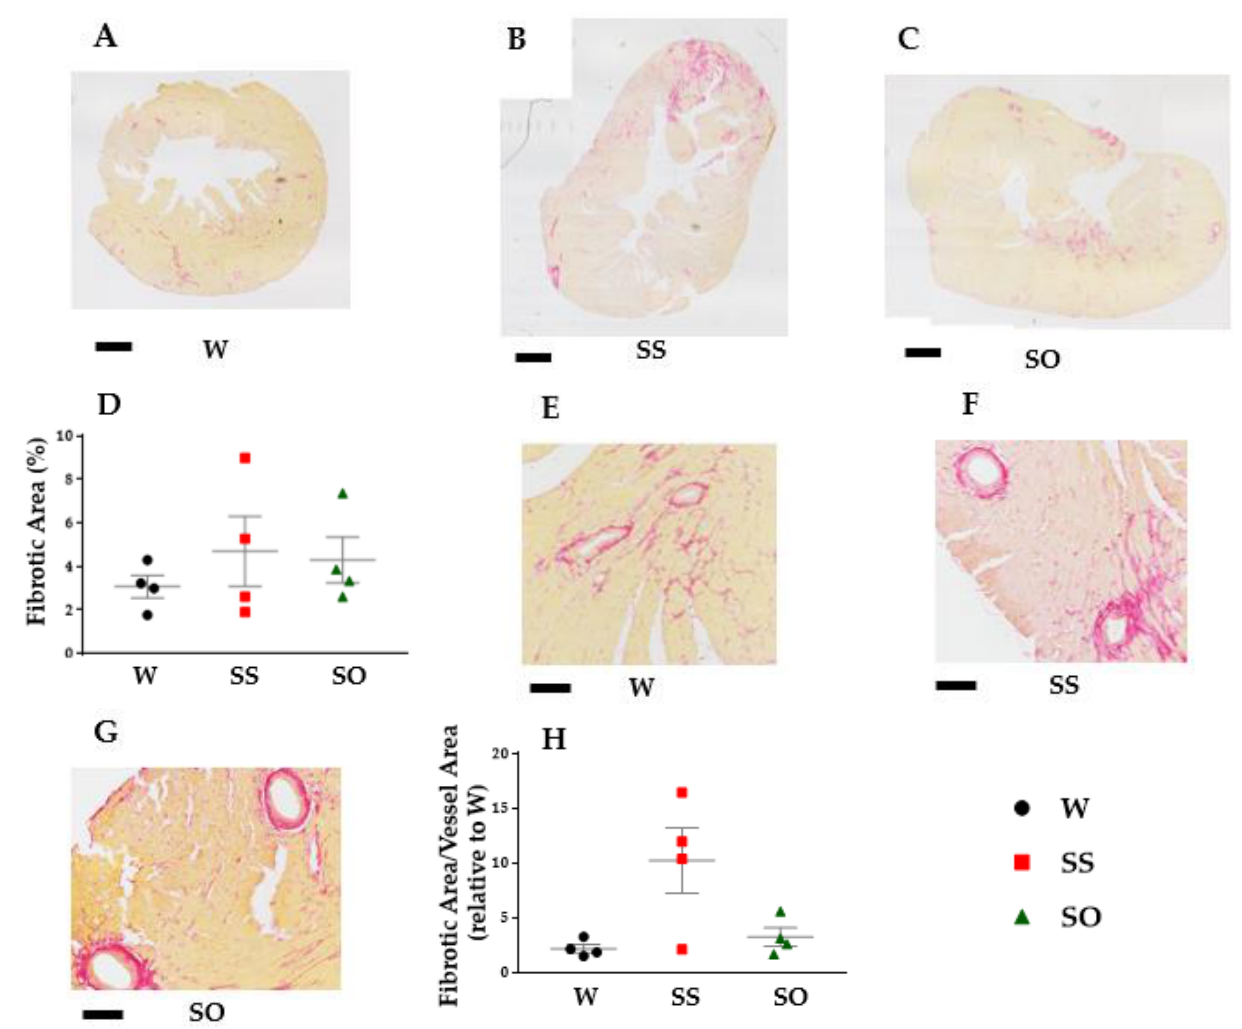
Figure 4. Effects of human omentin-1 on LV fibrosis in SHR. The heart was isolated from male SHR (65–68-weeks-old) subcutaneously injected with saline (0.14 mL/day, n = 4; SS) and human omentin-1 (18 µ g/kg/day, n = 4; SO) by using an implanted osmotic pump for 14 days or sham operated male WKY (n = 4; W). ( A – C ) The paraffin-embedded LV tissue sections were made and the representative results for picrosirius red staining were shown (A, W; B, SS; C, SO). ( D ) The interstitial fibrotic area (red) in LV tissue was measured with ImageJ software. The ratio (%) of fibrotic area (red) was calculated via dividing the red area by the whole tissue area (red and yellow) in LV. The results were shown as means ± S.E.M. ( E – G ) The paraffin-embedded LV tissue sections were made and the representative results for picrosirius red staining specifically focusing on small blood vessels are shown (E, W; F, SS; G, SO). ( H ) The perivascular fibrotic area (red area around the vessels) was corrected by each vessel area. The results were shown as fold increase relative to W (means ± S.E.M). Scale bars indicate 1.0 mm ( A – C ) or 0.2 mm ( E – G ). Statistical evaluations were performed using a One-way ANOVA followed by Bonferroni’s post-hoc